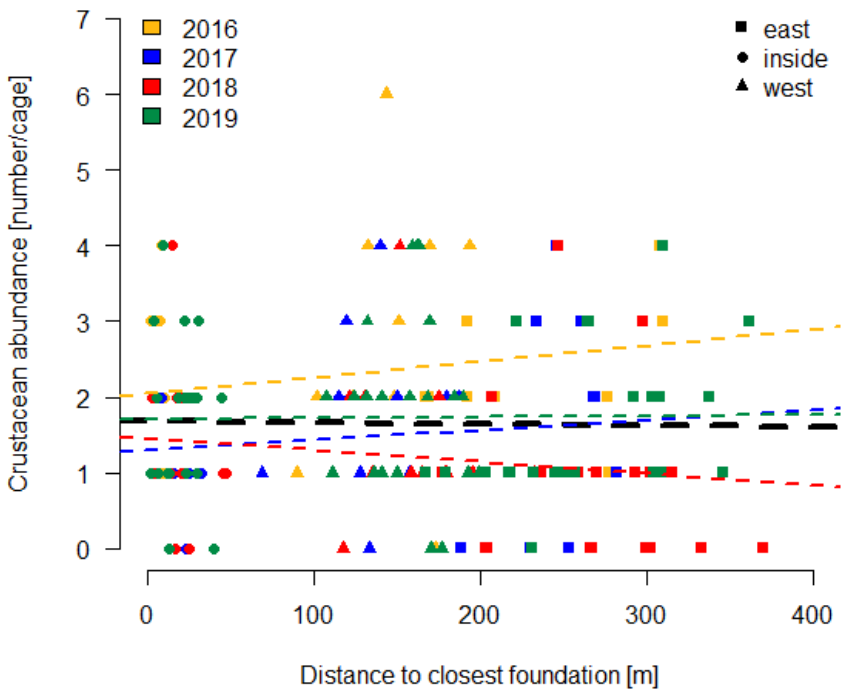
Figure 6. Number of decapods captured with the large cages in 2016–2019. Black dashed line represents pooled regression line of all years. Single years are represented by dashed lines in colors according to years in the legend. Table 3. Results of the linear models with number of decapods per cage as a function of distance to the closest ecological foundation (=D) for the different combinations of cage type and year.